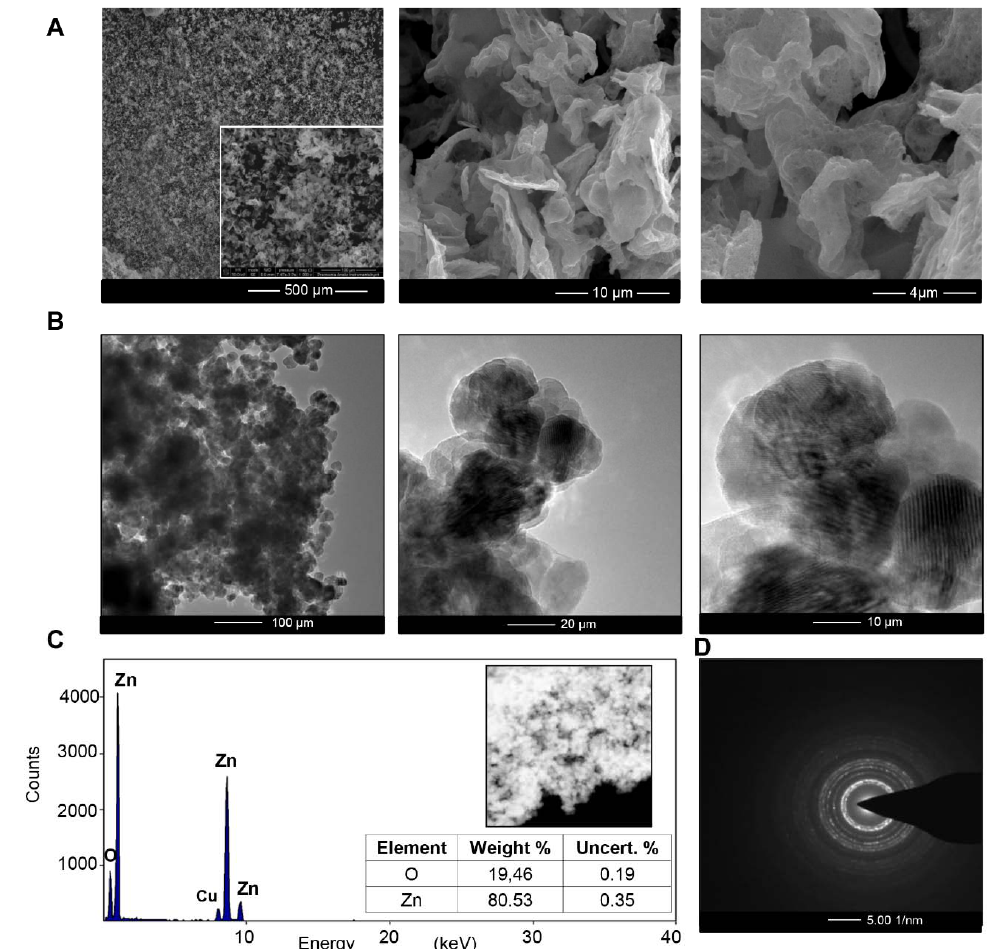
Figure 1. SEM micrograph ( A ), TEM micrograph ( B ), EDX spectra ( C ) and selected area (electron) diffraction (SAED) ( D ) of biologically synthesized ZnO NCs. di ff raction (SAED) ( D ) of biologically synthesized ZnO